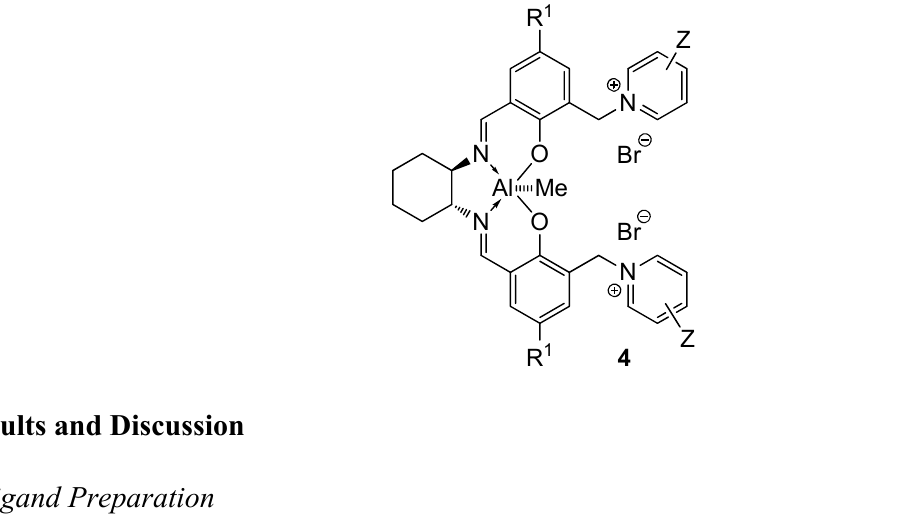
Figure 2. Structure of the investigated aluminum-bispyridinium catalysts 4 carrying different residues R 1 and pyridinium substituents